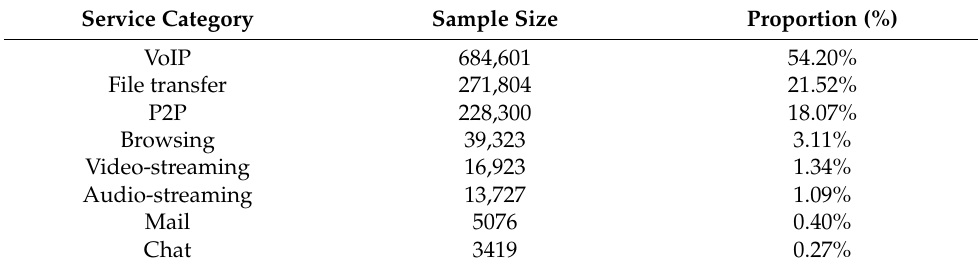
Table 3. Sample size and proportion in the